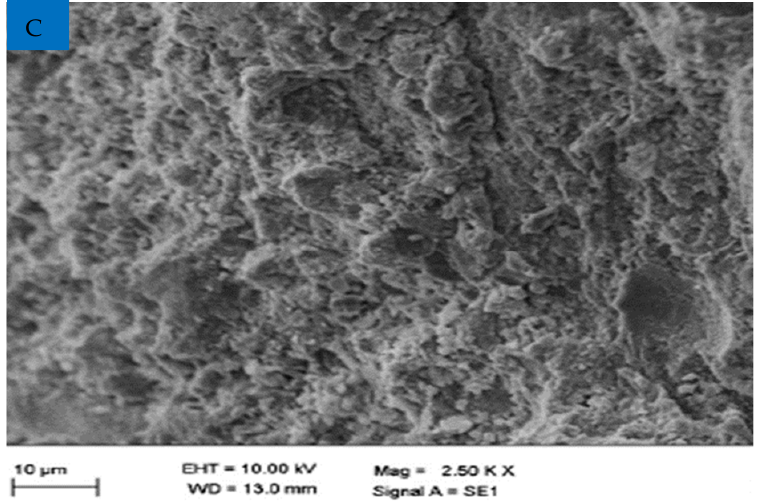
Figure 20. SEM Results, ( A ) 100% of CPS at 20 µm, ( B ) 100% of CPS at 10 µm and ( C ) 100% of CPS with 2% Nano Silica at 10 µm [74].